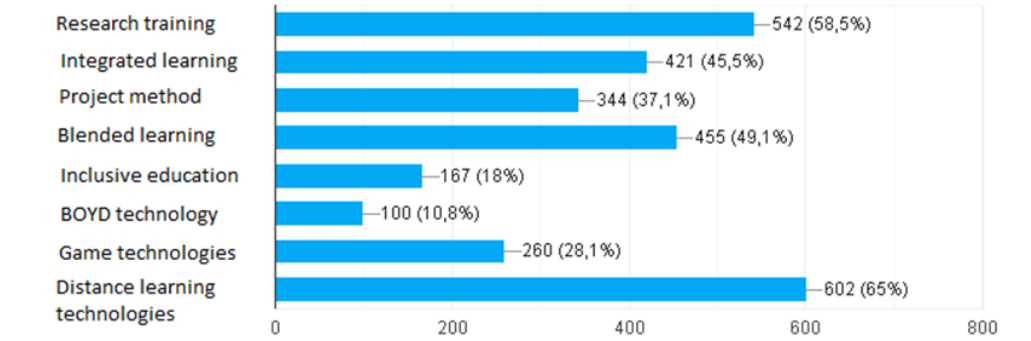
Figure 8: Distribution of respondents’ answers to the main requirements should be provided during the digital transformation of